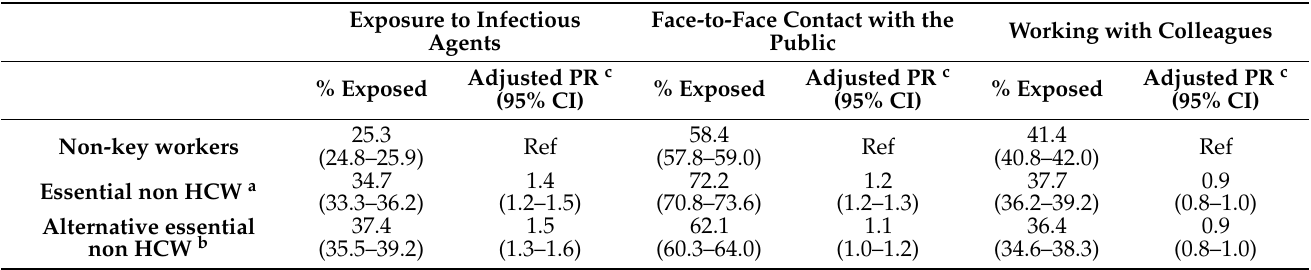
Table A3. Sensitivity analysis: prevalence ratio of exposure to the three work-related exposure factors based on different classifications of the essential non-HCW sub-group of key